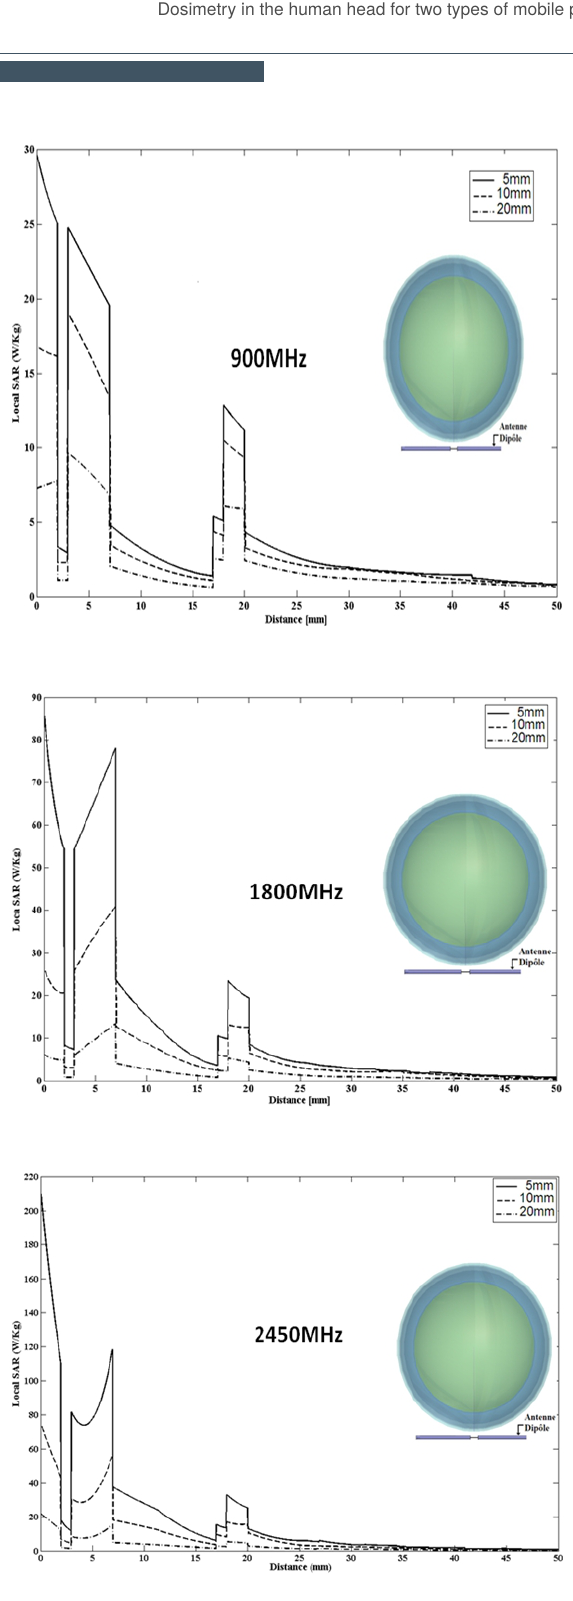
Figure 3. Local SAR variation at different distances dipole